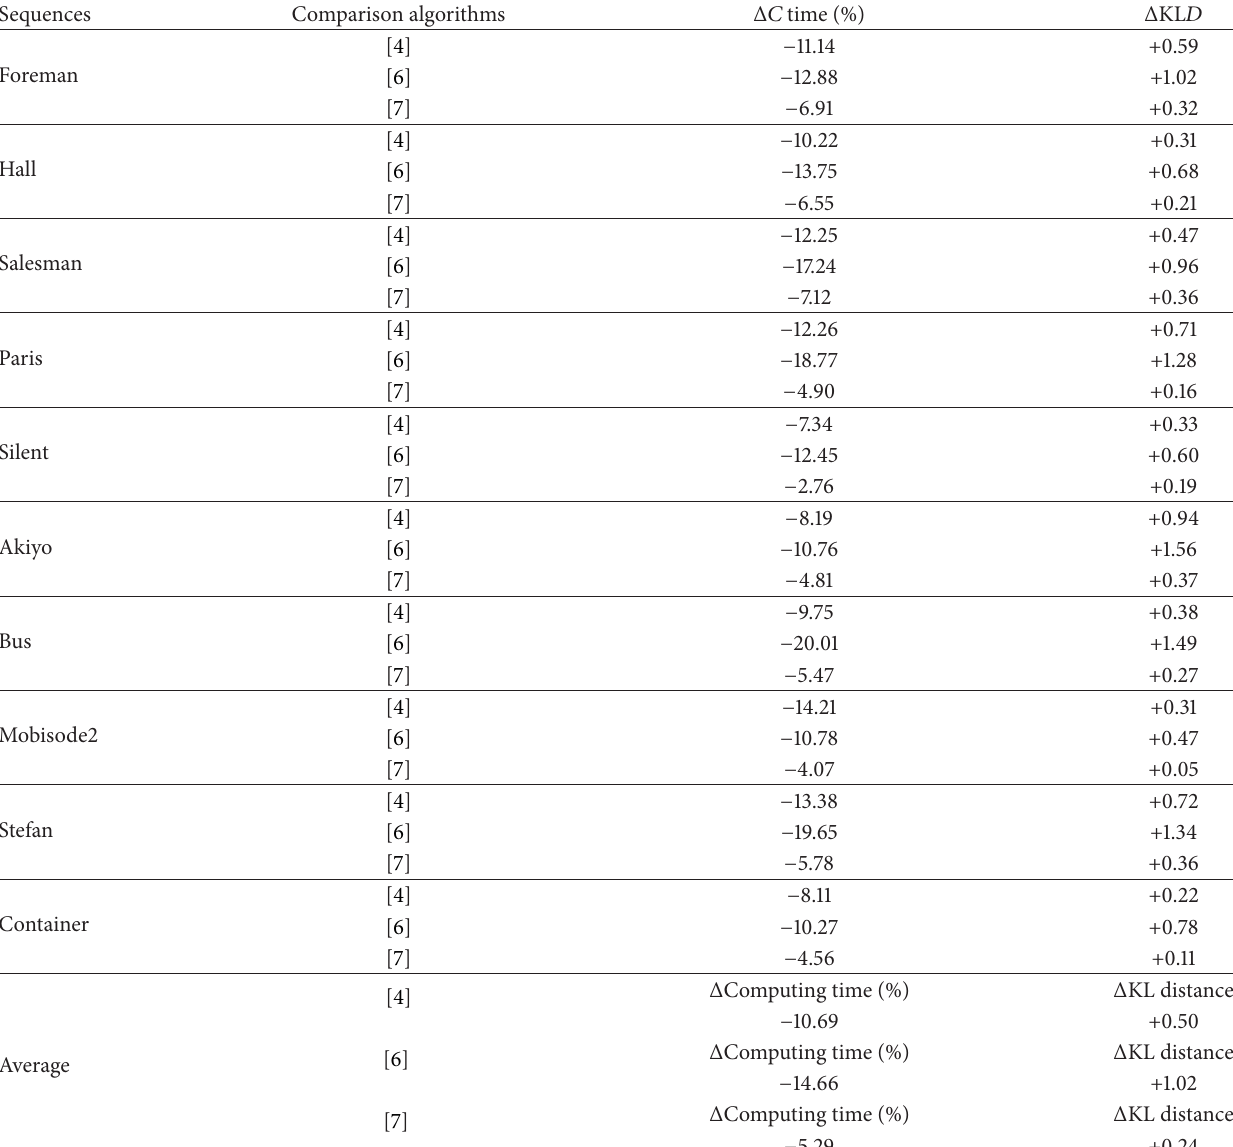
Table 6: Algorithms performance comparison